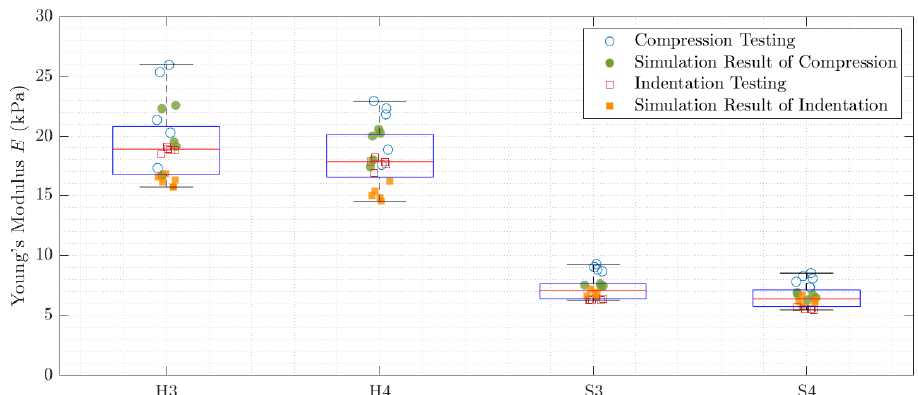
Figure 14. The mechanical evaluation methods are compared to each other in a statistical manner. The red line marks the median of all measurement results and the borders of the box indicate the 25th and 75th percentiles.